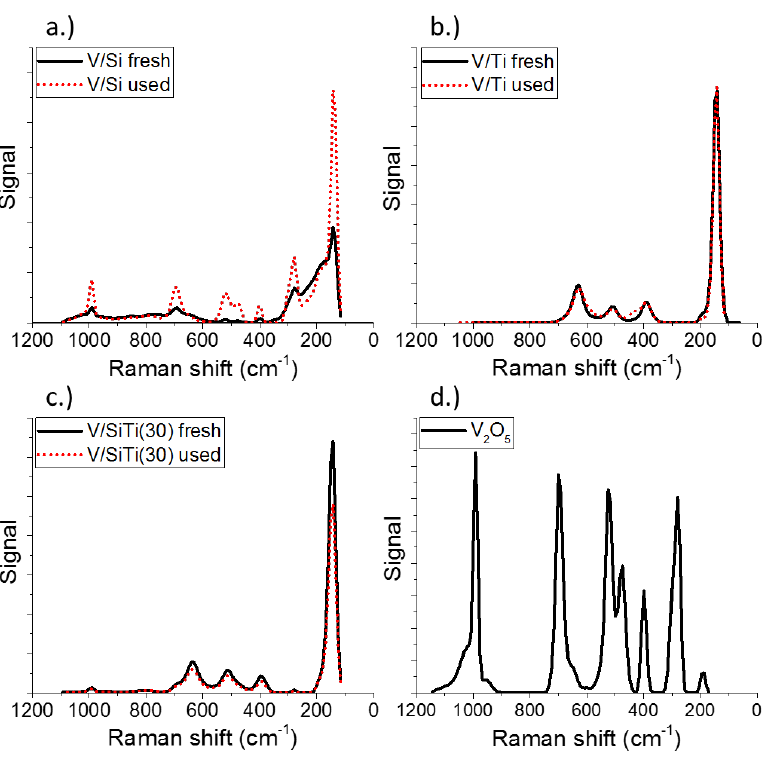
Figure 10. Timegated Raman spectra of ( a ) 1.5V/Si, ( b ) 1.5V/Ti, ( c ) 1.5V/SiTi(30) and ( d ) bulk V 2 O 5 .